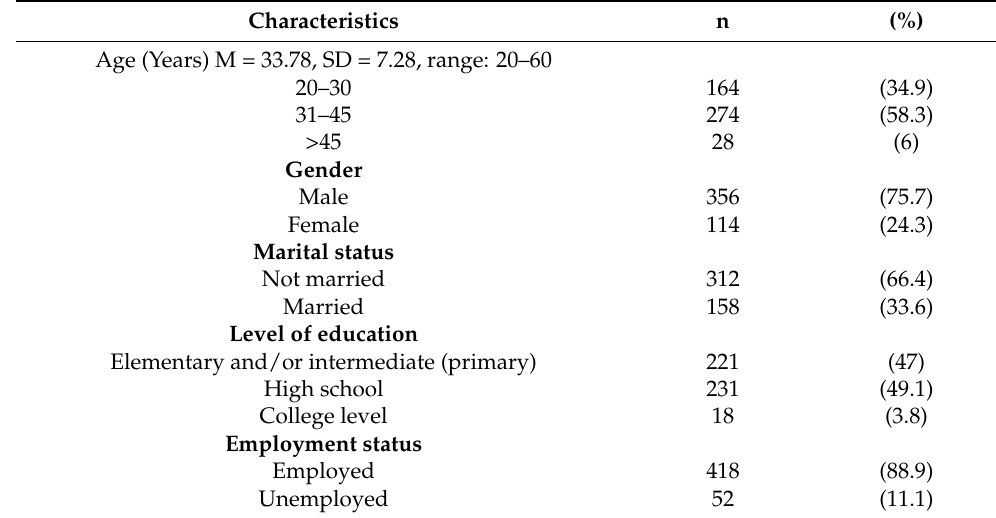
Table 1. Sample characteristics (N =